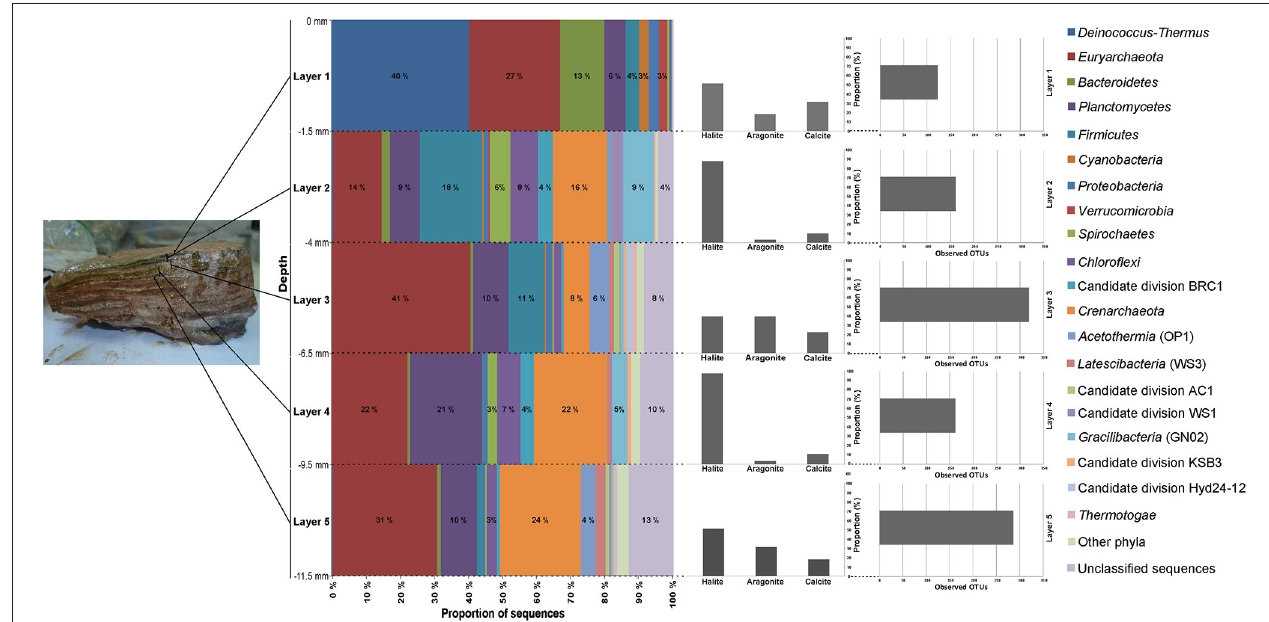
FIGURE 6 | Taxonomic composition by layers in MA1. Sequences were assigned taxonomically using Greengenes database with a minimum percentage similarity of 97% and a minimum e -value of 10 − 5